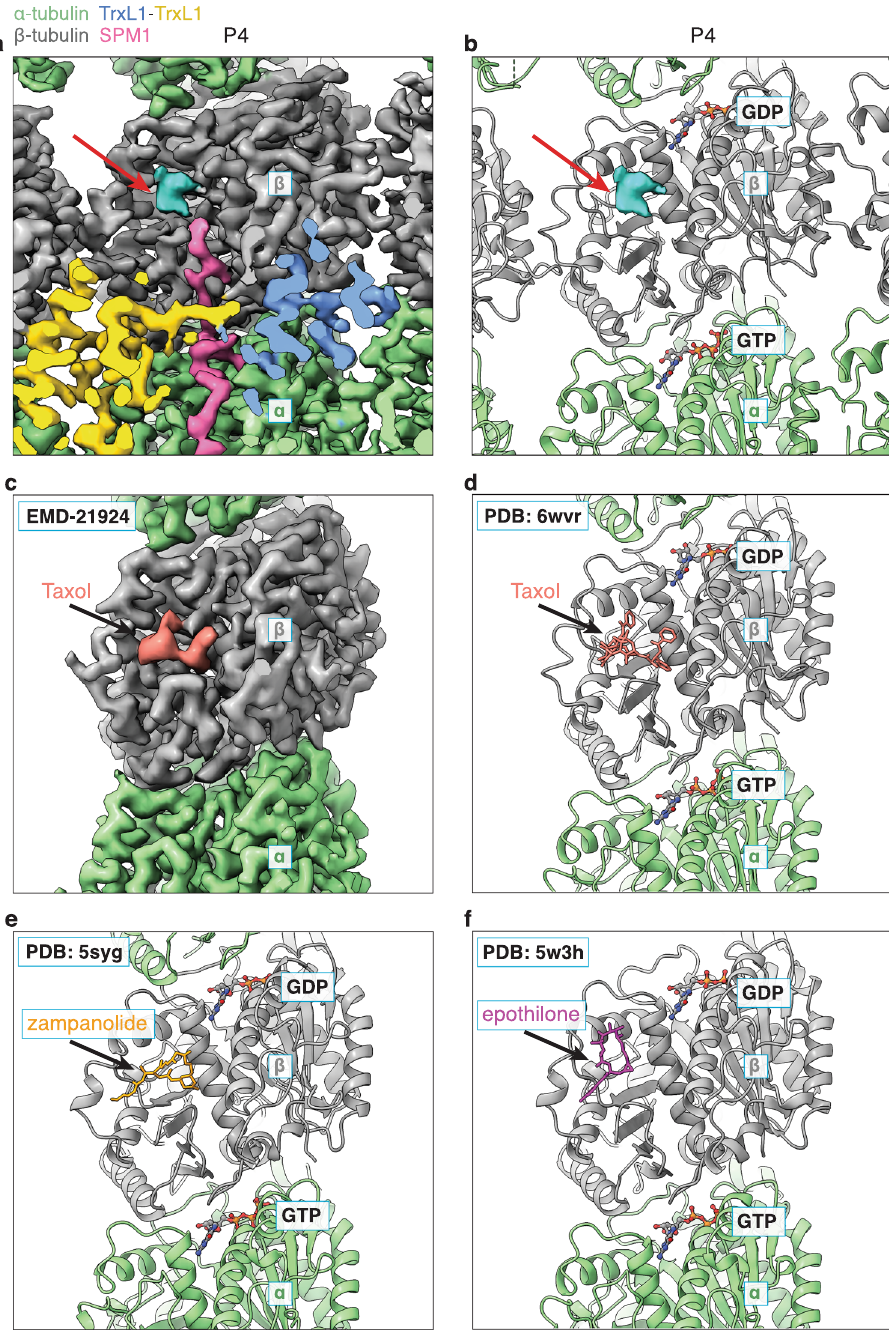
Fig. 4 Density at the Taxol-binding site of β -tubulin. a Close-up view of the cryo-EM density of one α , β -tubulin dimer at proto fi lament P4. Unexplained density (cyan, pointed by a red arrow) can be observed at the Taxol-binding site of β -tubulin (gray), but its size and shape are inconsistent with Taxol ( c , d ). b Same view as a, but showing the atomic models together with the unexplained density. Atomic models of TrxL1 and SPM1 are hidden for clarity. c Close-up view of the cryo-EM density of one α , β -tubulin dimer of taxol-stabilized bovine MT (EMD-21924) 66 . d Atomic model of the cryo-EM density shown in ( c ) (PDB 6WVR) 66 . e Atomic model of zampanolide-stabilized porcine MT (PDB 5SYG) 67 . f Atomic model of epothilone-stabilized yeast MT (PDB 5W3H) 68